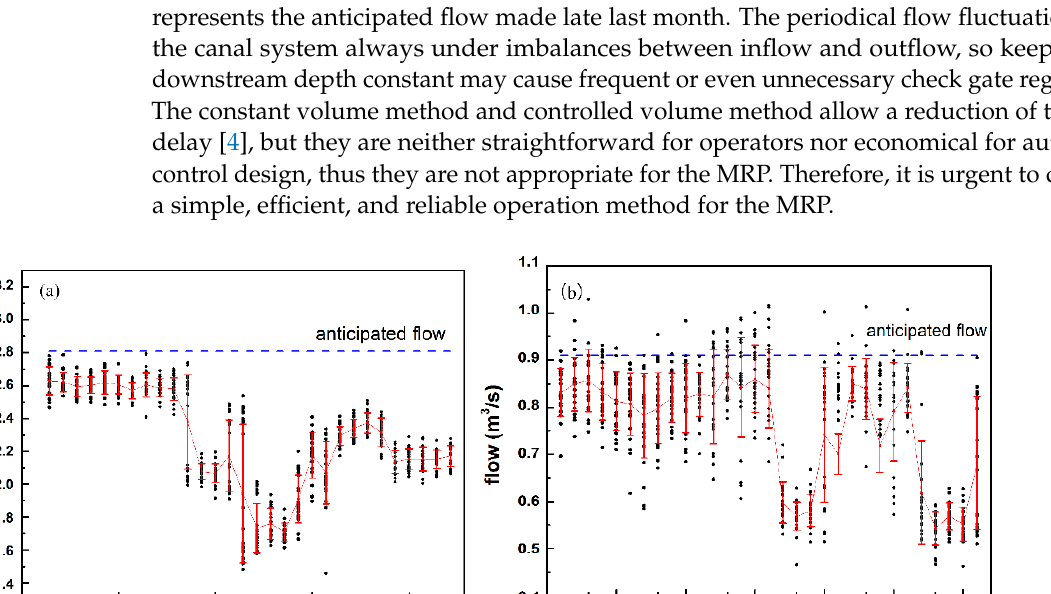
Figure 1. Route map of the Middle Route of South-to-North Water Diversion Project (MRP).